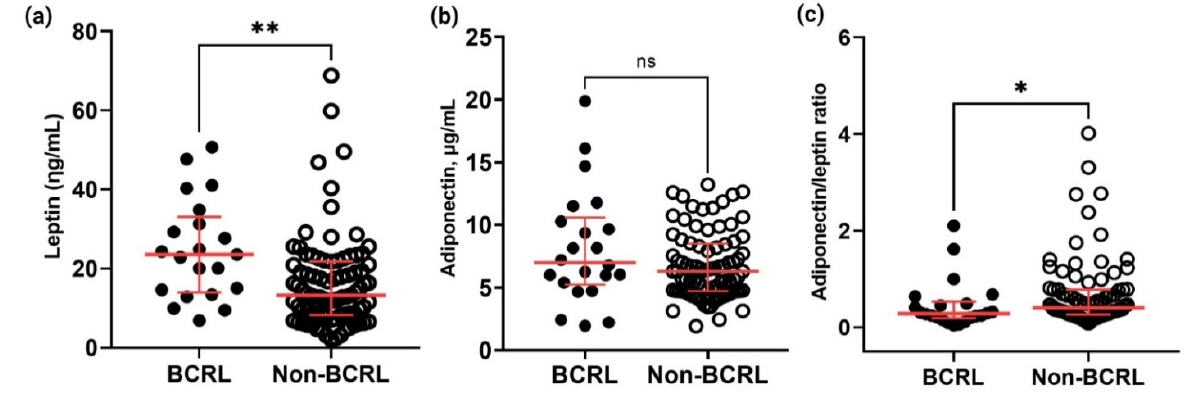
Figure 7. Comparison of the circulating leptin, adiponectin, and adiponectin/leptin ratio between the BCRL ( n = 22) and non-BCRL group ( n = 86). The levels of ( a ) leptin and ( b ) adiponectin were quantified by ELISA, whereas the ( c ) adiponectin/leptin ratio was calculated using a formula ((Adiponectin ( μ g/mL))/(Leptin ( η g/mL))). The horizontal black lines indicate a comparison line between the two groups and significant values were calculated by Mann–Whitney U test, p < 0.05. Asterisks in the figures represent statistical significance (* p < 0.05 and ** p < 0.001) and ns indicates non-significance. Samples were run in triplicate and the precision (CV%) of intra-assays were maintained between 10–15%. All data are presented as the median and error bars represent IQR.